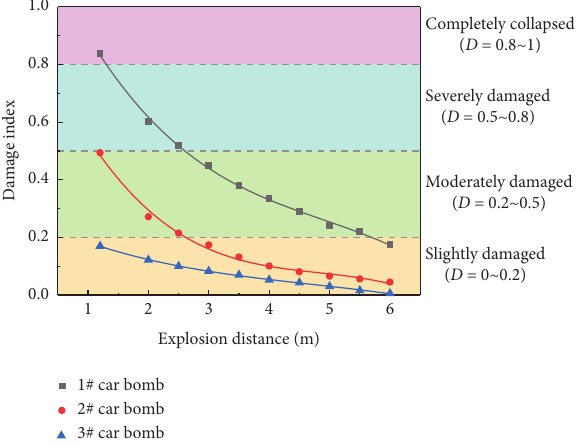
Figure 9: Damage index-explosion distance curves.